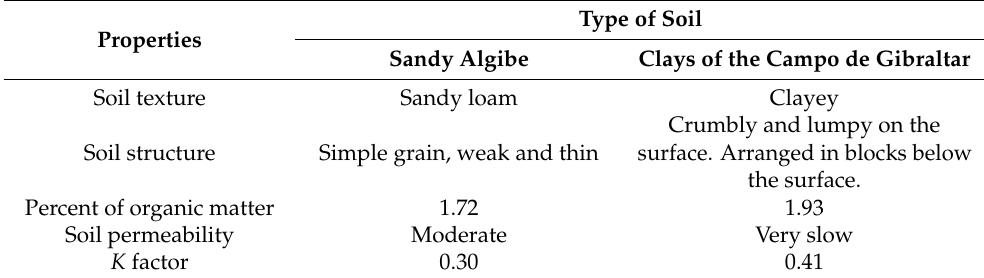
Table 3. Soil units (K